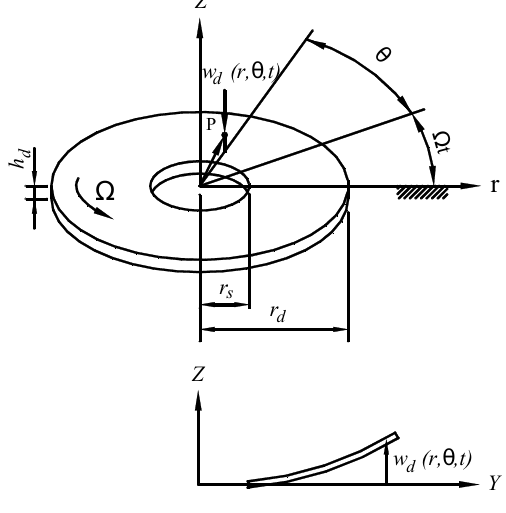
Fig. 2. The geometry and coordinates of the rotating